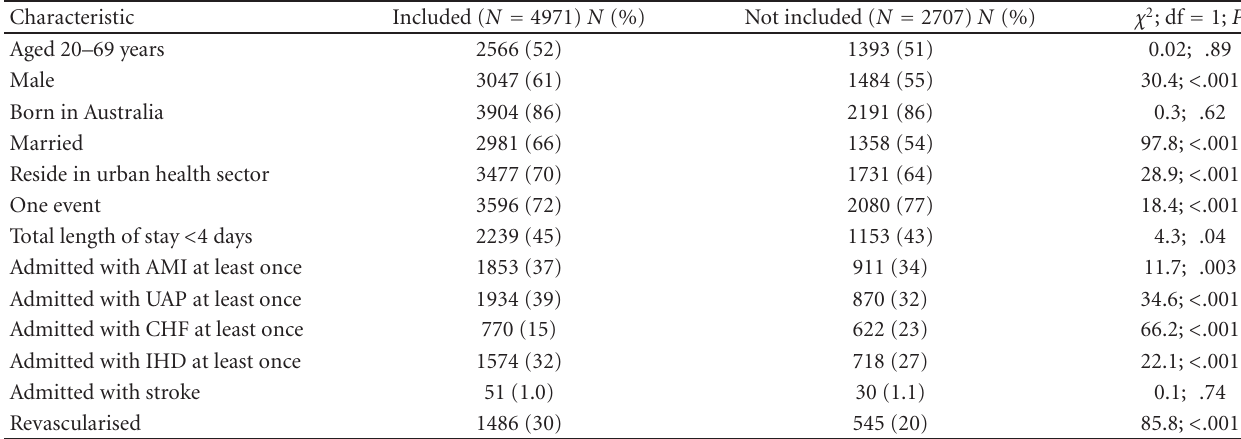
Table 1: Demographic and clinical characteristics of consenters and nonconsenters.